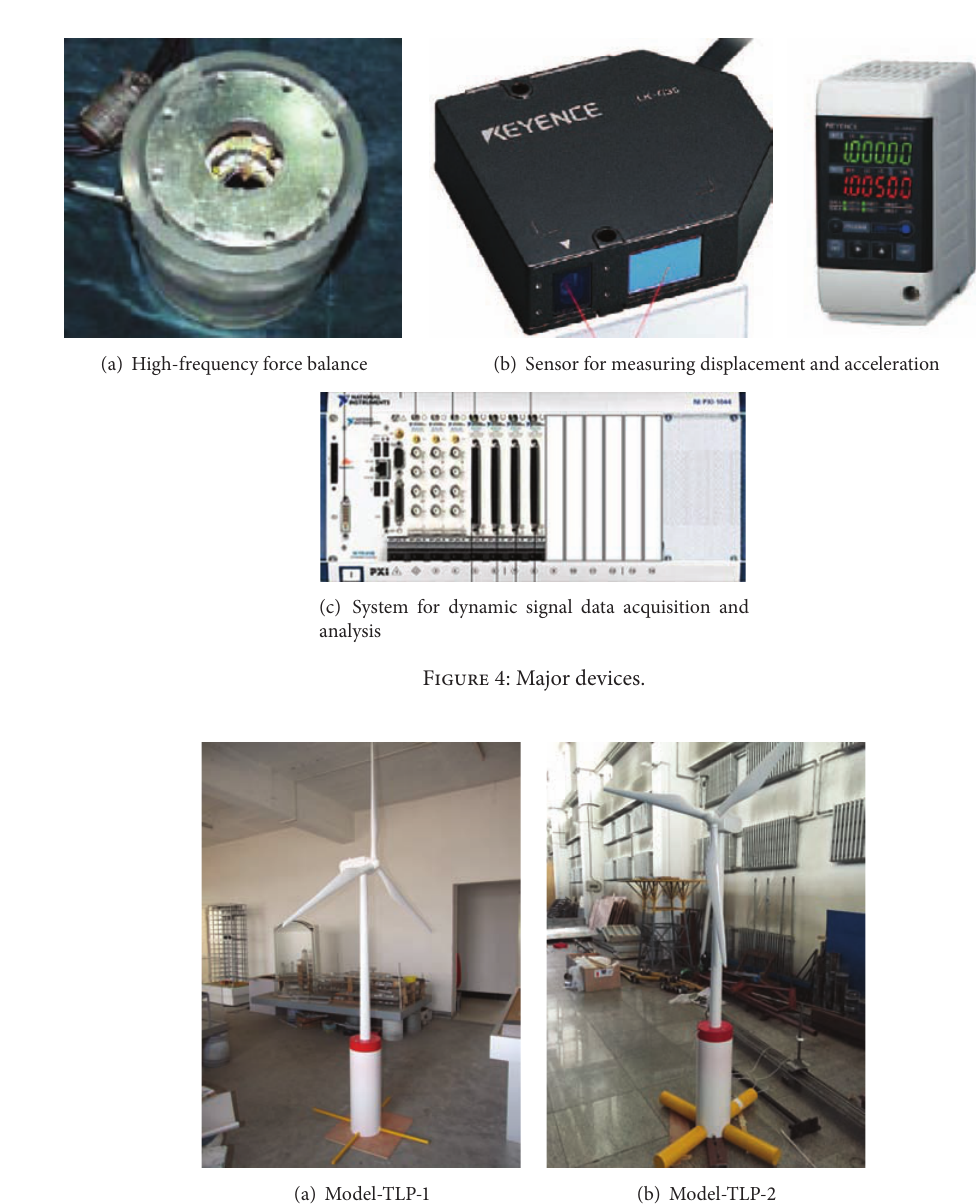
Figure 5: Model-TLP-1 and